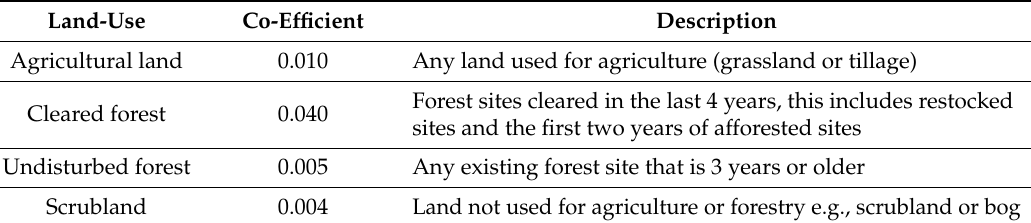
Table A11. Land-use coefficients for water sedimentation risk calculation.